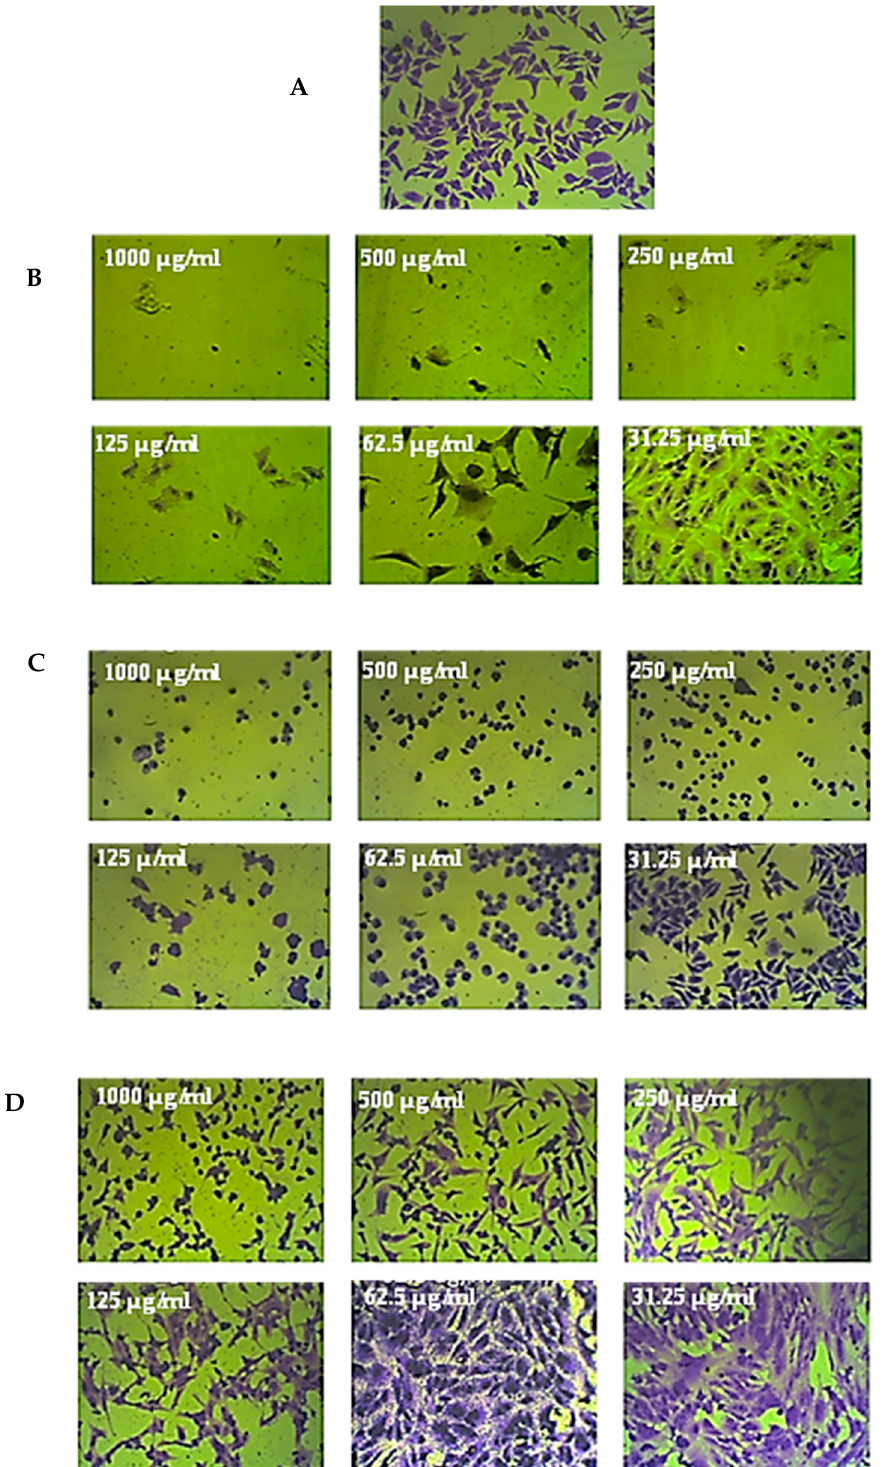
Figure 5. An example of the moderate anticancer effects of the stem extract of R. micronata against colon cancer cell lines (CaCo-2). ( A ) Complete monolayer sheets of colon cancer cell lines (CaCo-2) that have not been treated. ( B ) The effect of doxorubicin treatment at different concentrations. ( C ) The effect of the stem extract of R. micronata against CaCo-2 cell lines at different concentrations. ( D ) The effect of the stem extract of R. micronata against normal human fetal lung fibroblasts (WI-38) at different concentrations.